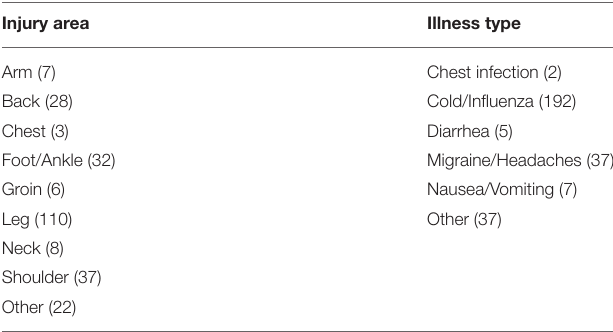
TABLE 5 | Injury and illness reported by the athletes during the